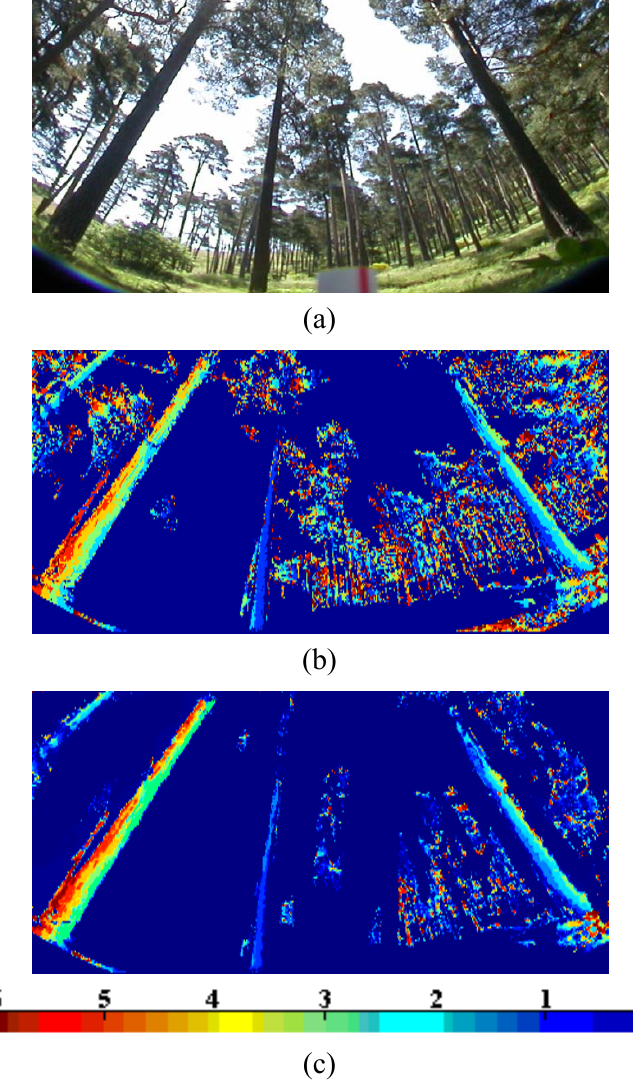
Figure 4. (a) Expanded area corresponding to the signed area in the image of Figure 1(a); (b) disparity map obtained by the WFS approach; (c) disparity map obtained by the HNN